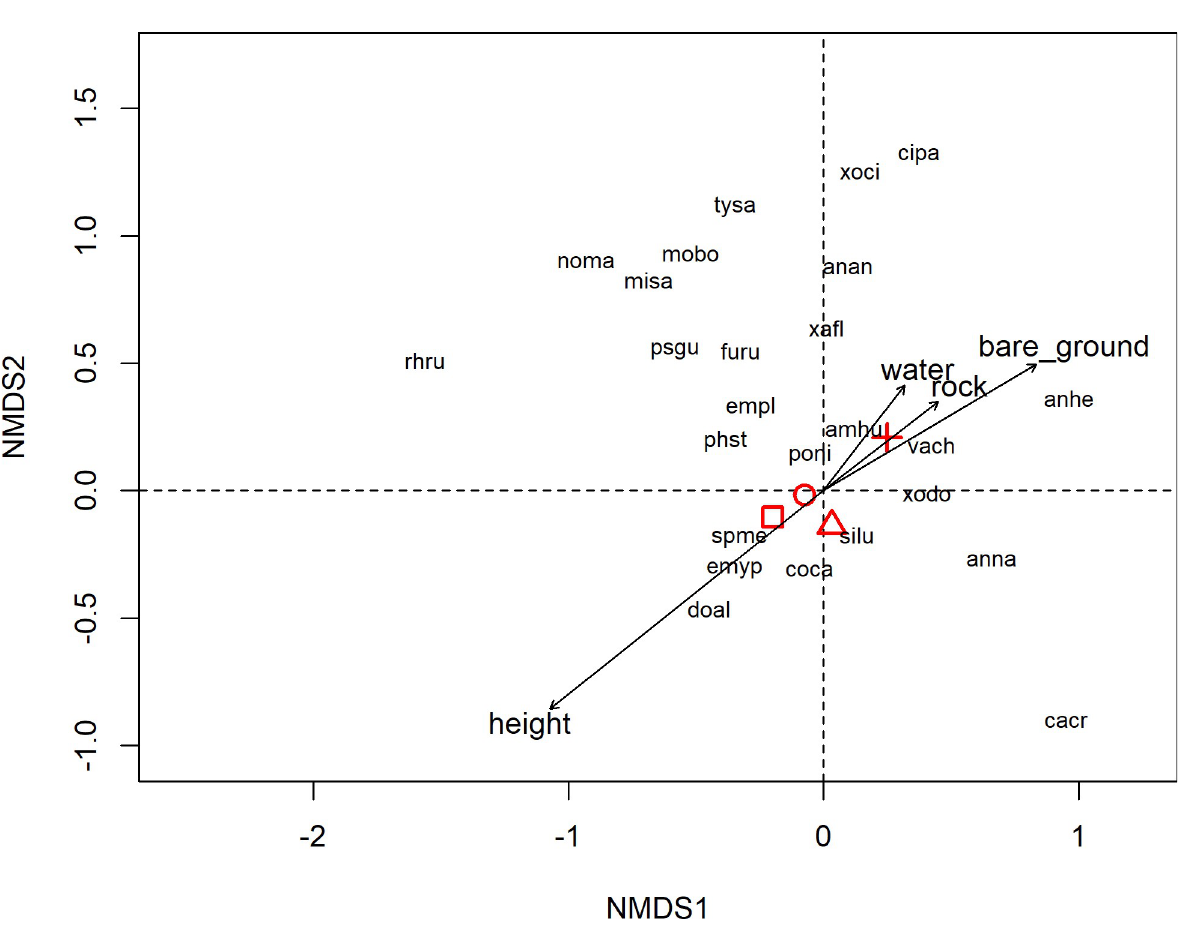
Fig 5. Non-metric multidimensional scaling (NMDS) plot illustrating the association among the grassland birds, four environmental variables (vegetation height, bare ground, rocks, and water) and a time gradient in relation to the fire disturbance. Results based on the species abundance (Bray-Curtis dissimilarity index) in areas with occasional fire (i.e. burned only once during the study). Stress = 0.22. Symbols represent the mean scores (centroids) of each breeding season (square = before the fire; cross = year of fire; circle = one year post-fire; triangle = two years post-fire). Acronyms are formed by the first two letters of the genus and species epithet of species in S2 Table.